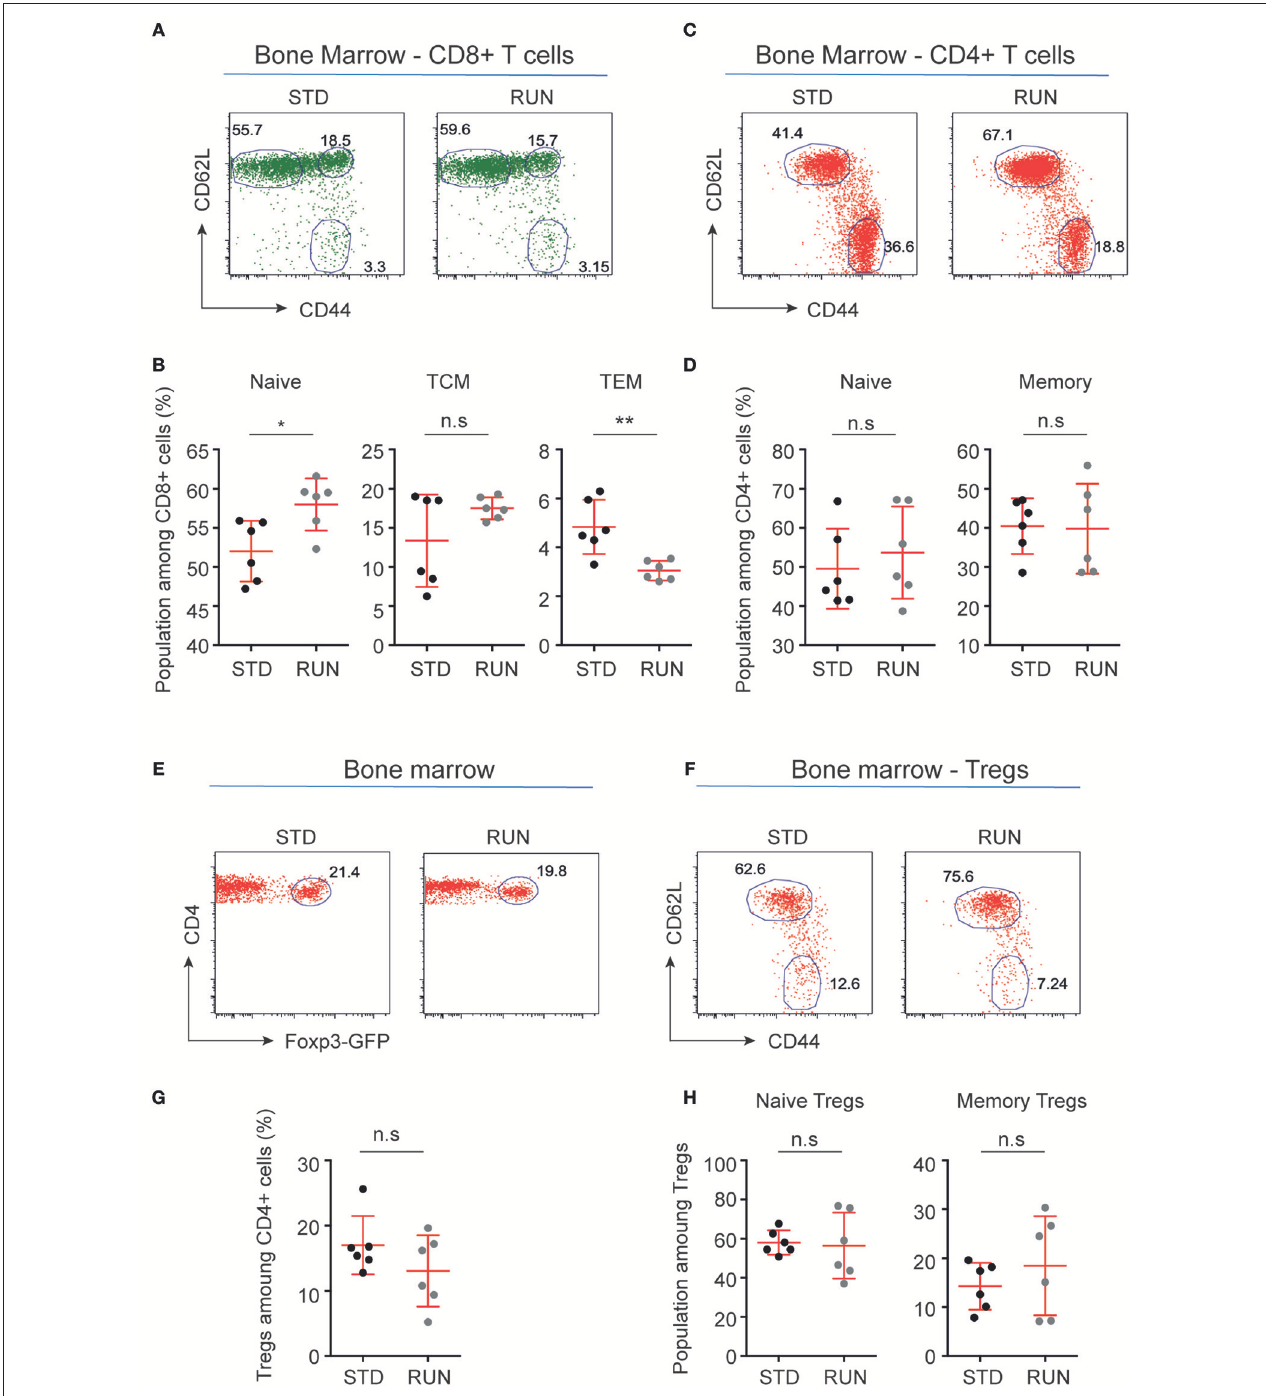
FIGURE 7 | Maturation stages of CD8 + and CD4 + T cells and Tregs in the bone marrow of STD and RUN mice. (A,C) Representative dot plots of CD62L and CD44 expression on CD8 + (A) and CD4 + (C) T cells in the bone marrow of mice that were housed under STD or RUN conditions. (B) Composite frequencies of naive, central memory (TCM), and effector memory (TEM) T cells among CD8 + T cells in the bone marrow. (D) Composite frequencies of naive and memory T cells among CD4 + T cells in the bone marrow. (E) Representative dot plots depicting the expression of Foxp3-GFP among gated CD4 + T cells in the bone marrow of mice that were housed under STD or RUN conditions. (G) Composite frequencies of Foxp3 + Tregs among CD4 + T cells in the bone marrow. (F) Representative dot plots depicting the expression of the maturation markers CD62L and CD44 on Foxp3 + Tregs. (H) Composite percentages of naive and memory Tregs in the bone marrow of STD and RUN mice after 4 days of running. Numbers in dot plots in (B,D,G,H) indicate the percentages of cells within the respective gate. Symbols and horizontal lines indicate individual mice and mean values ± SD, respectively. The level of significance was determined by a two-tailed Mann Whitney test. Data were compiled from two independent experiments. * p < 0.05, ** p <